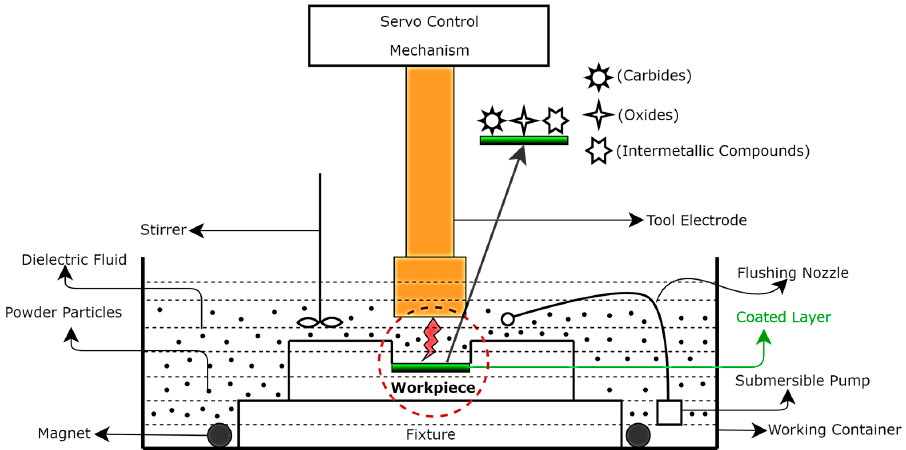
Figure 1. Typical arrangement of PMEDM system.